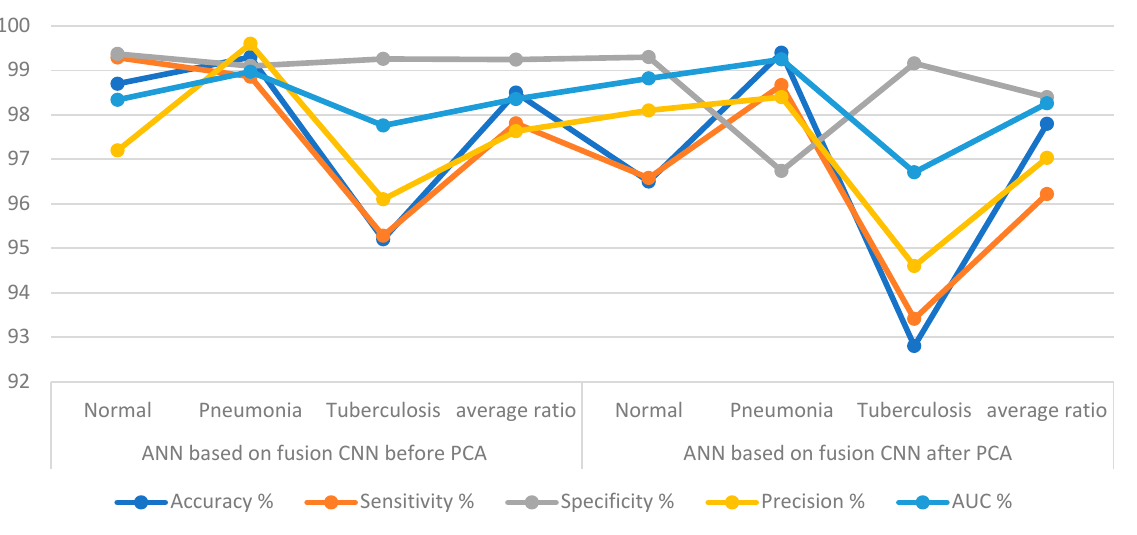
Figure 9. The ANN performance based on integrating the features for the X-ray diagnostics of the pneumonia and tuberculosis data set.